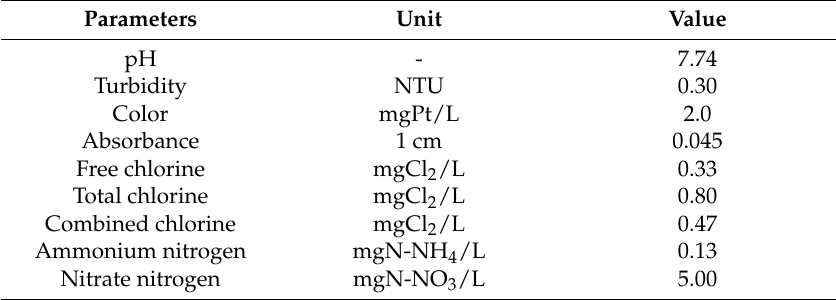
Table 1. The results of basic quality analysis of tested swimming pool water.